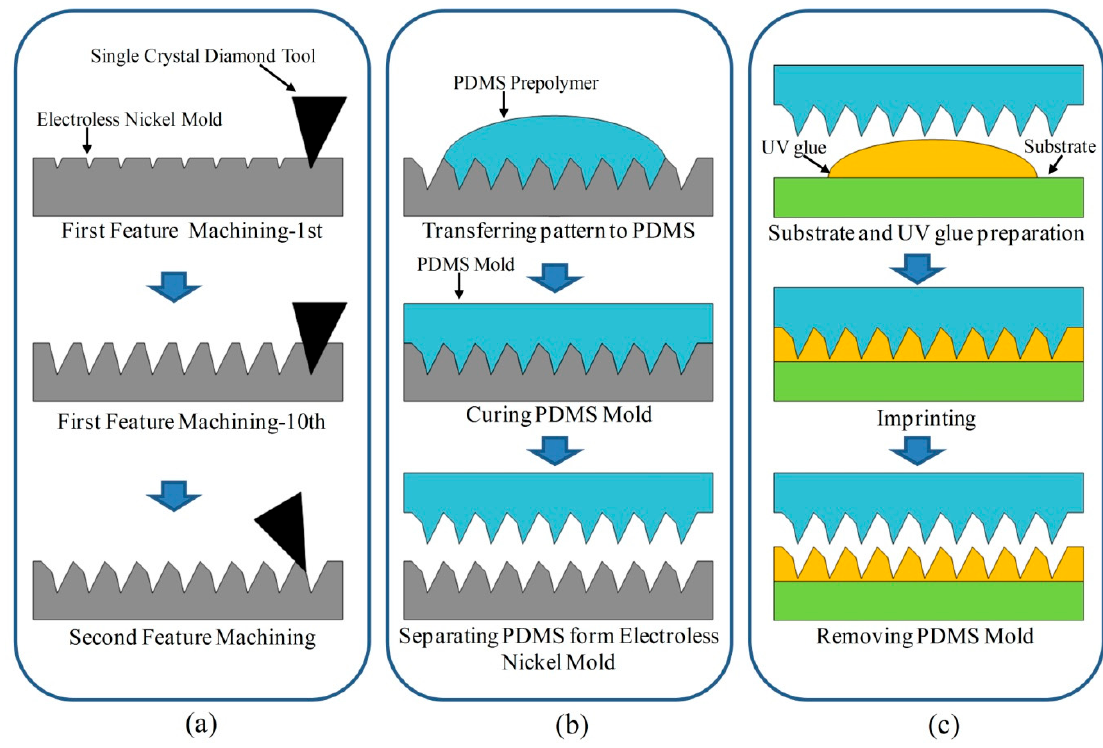
Figure 5. Fabrication process of the sunlight guiding panel that include: ( a ) Cutting the pattern of the polygonal prism, ( b ) transferring the pattern to a polydimethylsiloxane (PDMS) mold, and ( c ) imprinting the polygonal prism of the sunlight guiding panel.